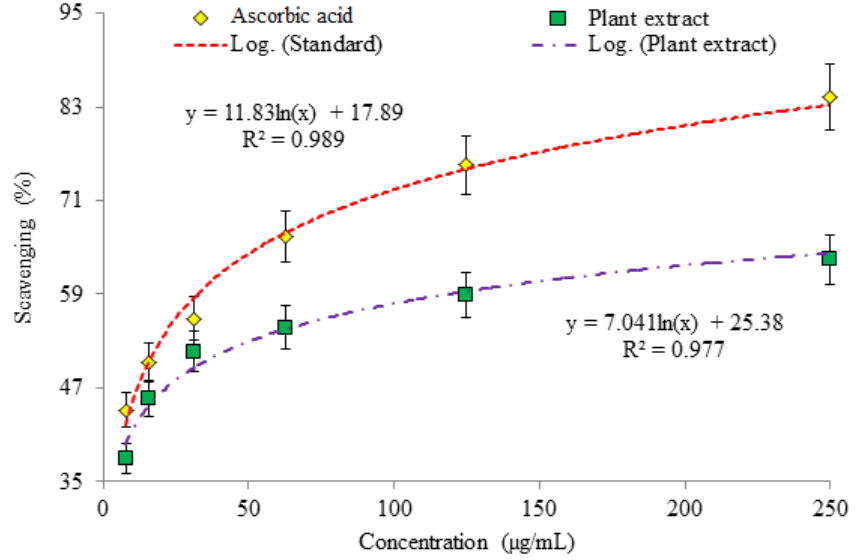
Figure 1. Percentage inhibition of ascorbic acid and plant extract in DPPH assay.